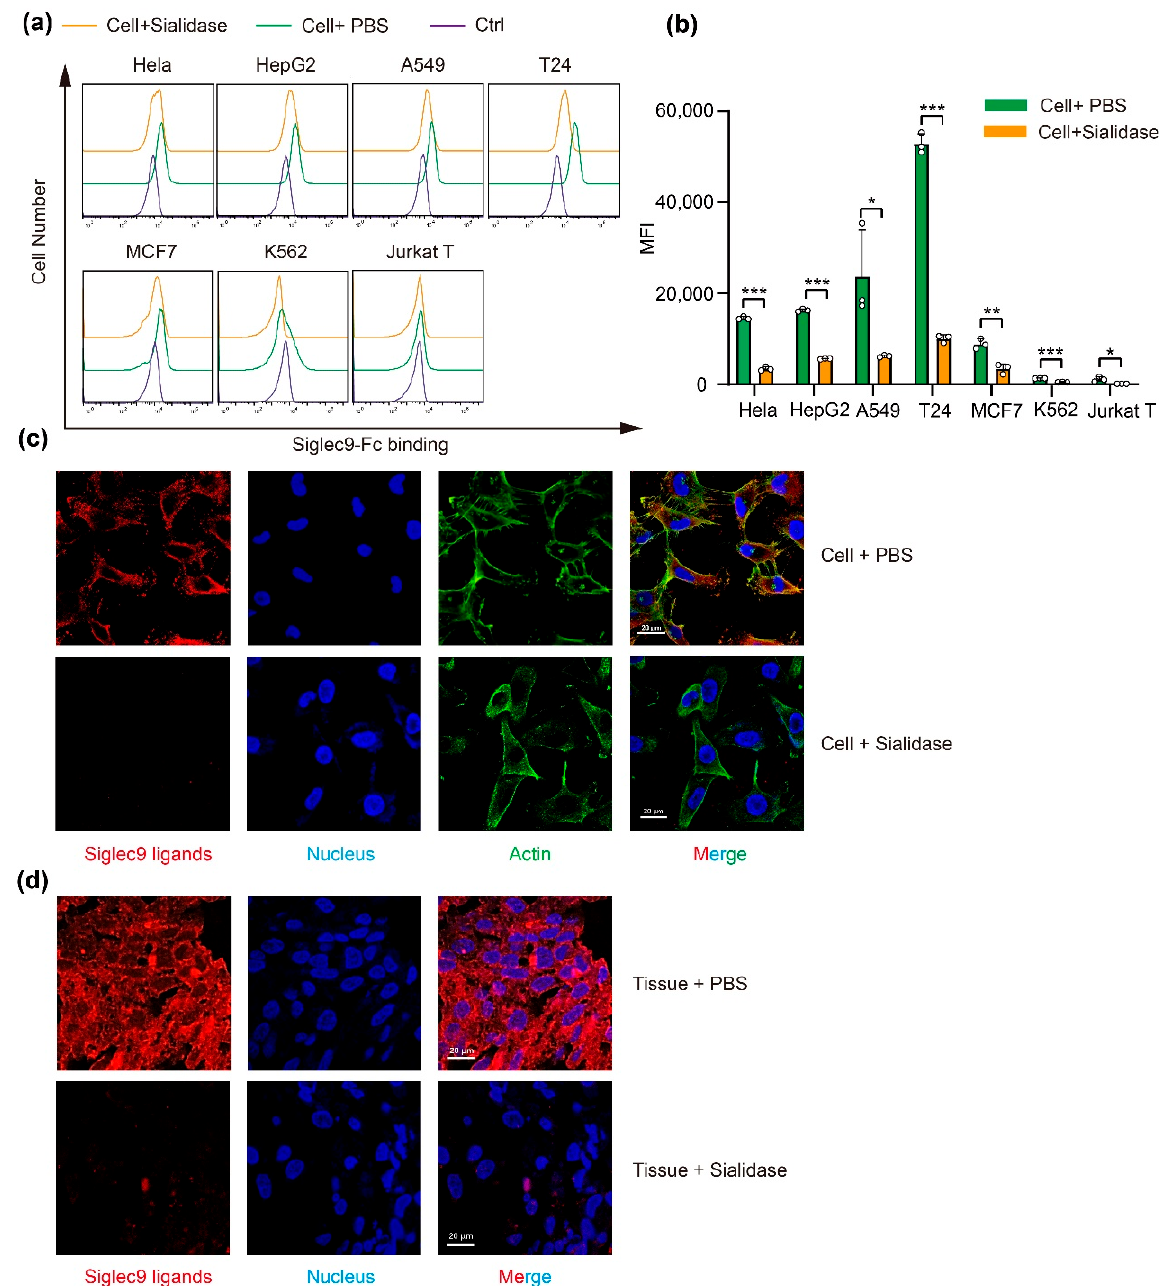
Figure 4. Siglec9 ligands widely expressed on cancer cell lines and bladder cancer tissue. ( a ) Flow cytometry analysis of Siglec9-Fc binding on cancer cells of different tissue origin before or after sialidase treatment; ( b ) quantification of flow cytometry analysis of the Siglec9-Fc binding. Data presented as mean values ± SD. Statistics: unpaired two-tailed Student’s t-test (* p < 0.05, ** p < 0.01, and *** p < 0.001); Siglec9-Fc binding intensity on the bladder cancer cell T24 ( c ) and bladder cancer tissue ( d ), which decreased after sialidase treatment shown by confocal microscopy. Red: Siglec9 ligands, stained by Siglec9-Fc and PE-anti human IgG, Blue: nucleus, stained by DAPI, Green: actin, stained by Actin-Tracker Green.